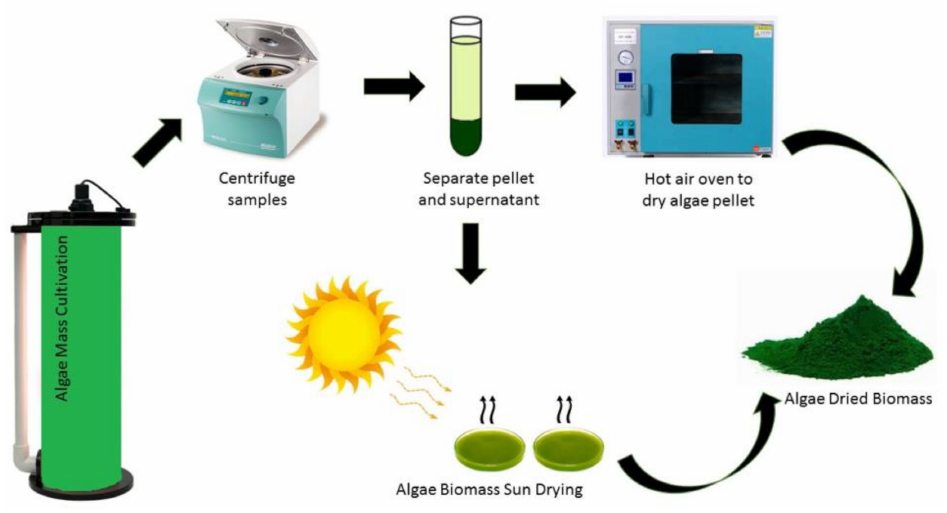
Figure 3. Microalgae harvesting and biomass